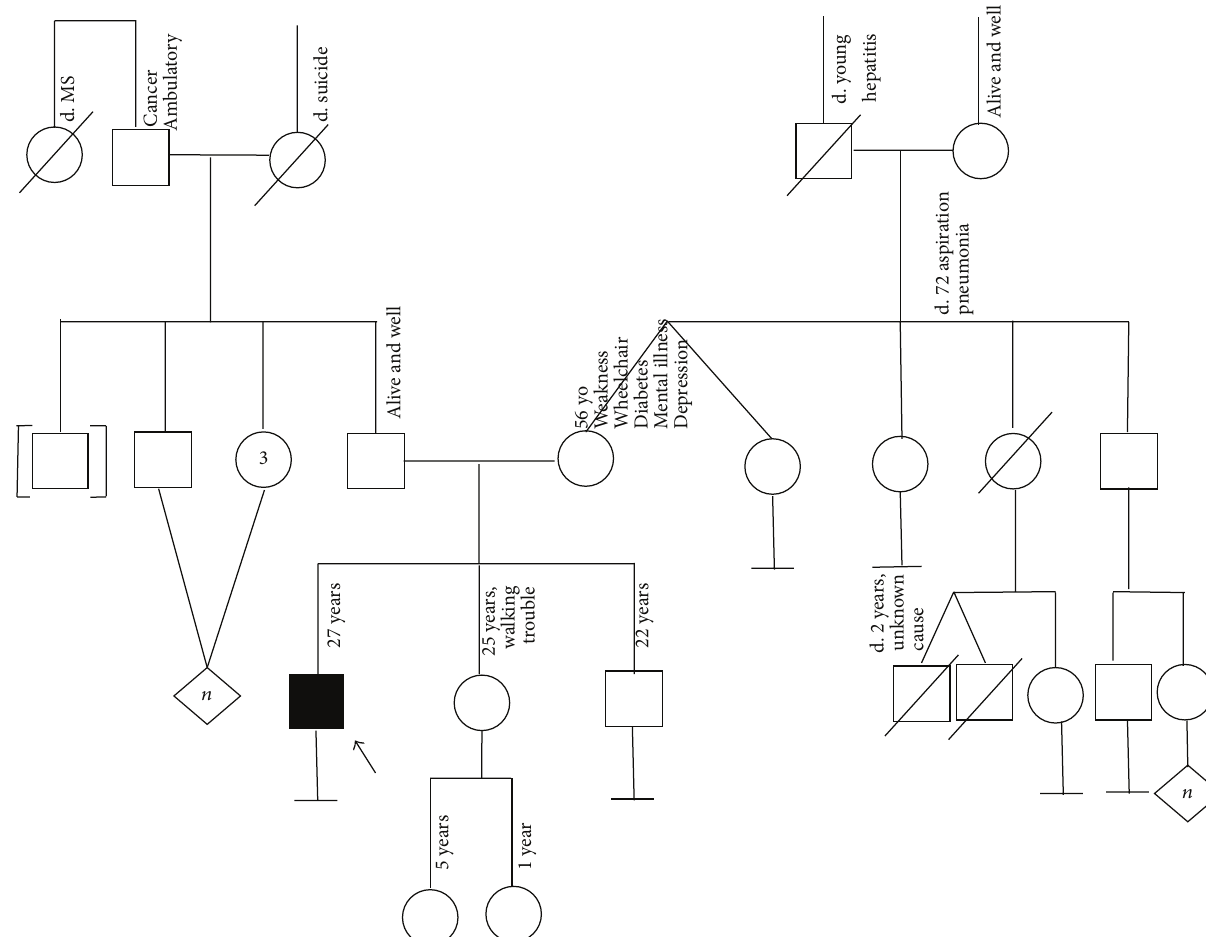
Figure 1: Family pedigree. Squares indicate men; circles indicate women; diagonal lines indicate deceased; black indicates KIF5A mutation. An arrow indicates the proband. “ 𝑛 ” stands for number of unaffected